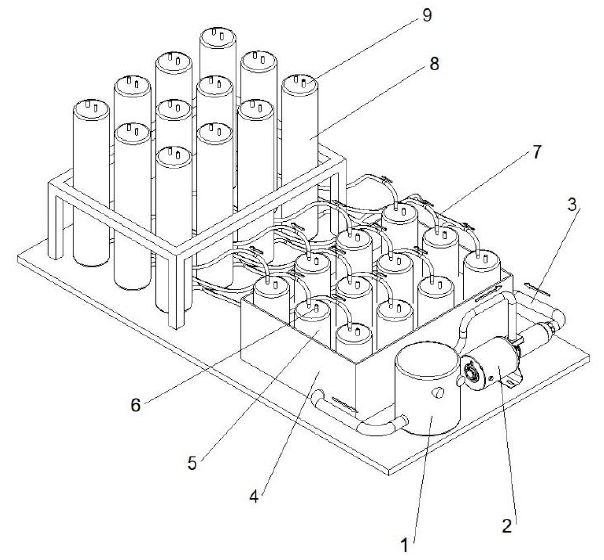
Figure 2. Anaerobic bioreactor used in biogas production experiment: 1—water heater; 2—water pump; 3—insulated tubes for heating medium; 4—water jacket (39 °C); 5—bioreactor (1.4 L); 6—slurry sampling valve; 7—tube for biogas transport; 8—graduated tank for biogas; 9—gas sampling valve (authors’ own elaboration).